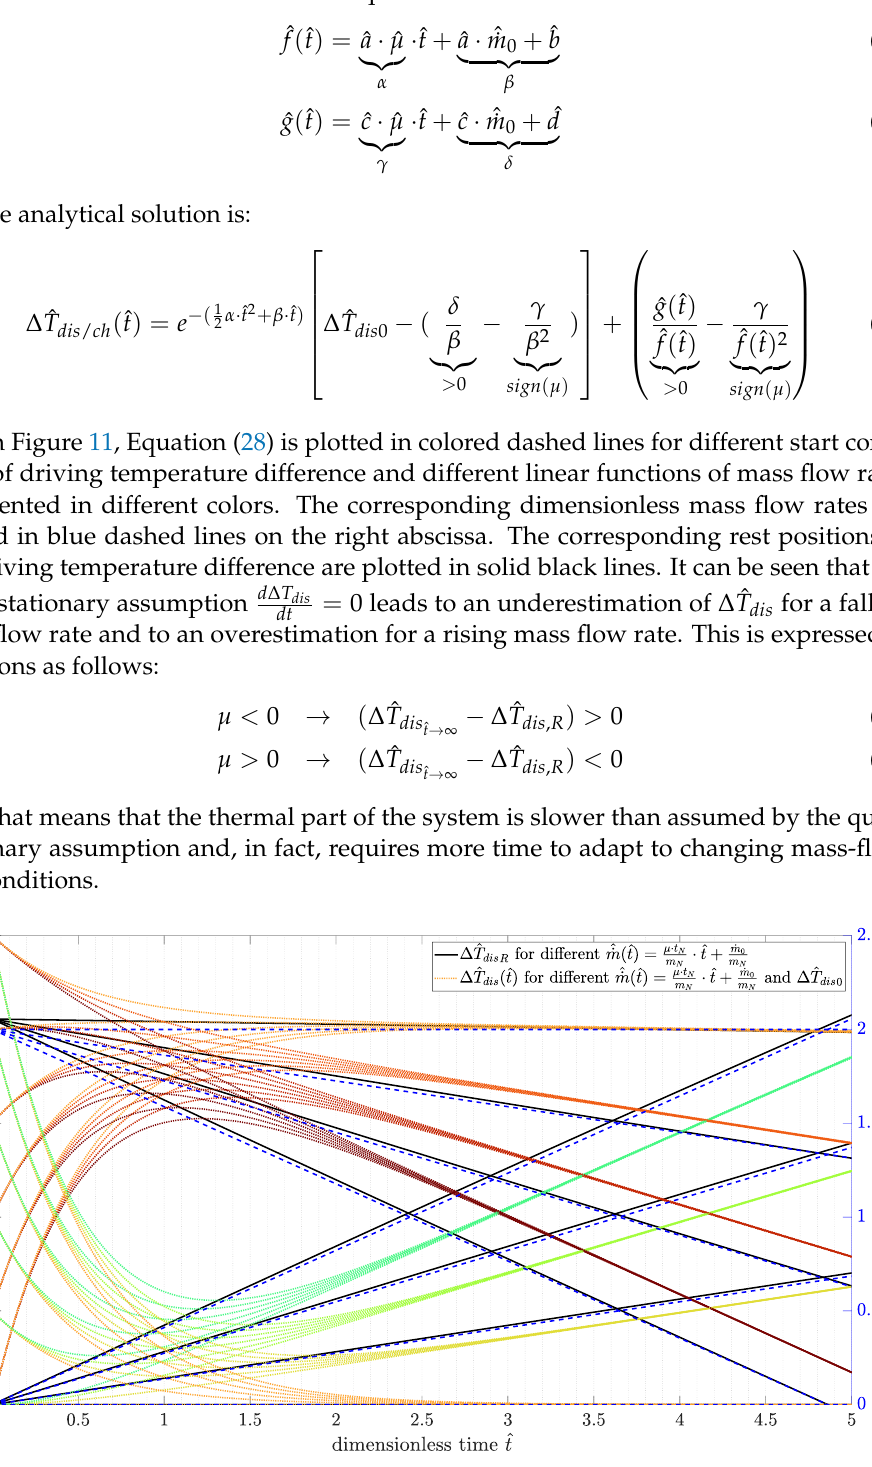
Figure 11. Non-dimensional driving temperature difference over non-dimensional time for different linearly rising and falling vapor mass flow rates ˆ˙ m ( ˆ t ) and different start values ∆ ˆ T dis ,0 . Corresponding rest positions ˆ ∆ T disR ( ˆ t ) in solid black